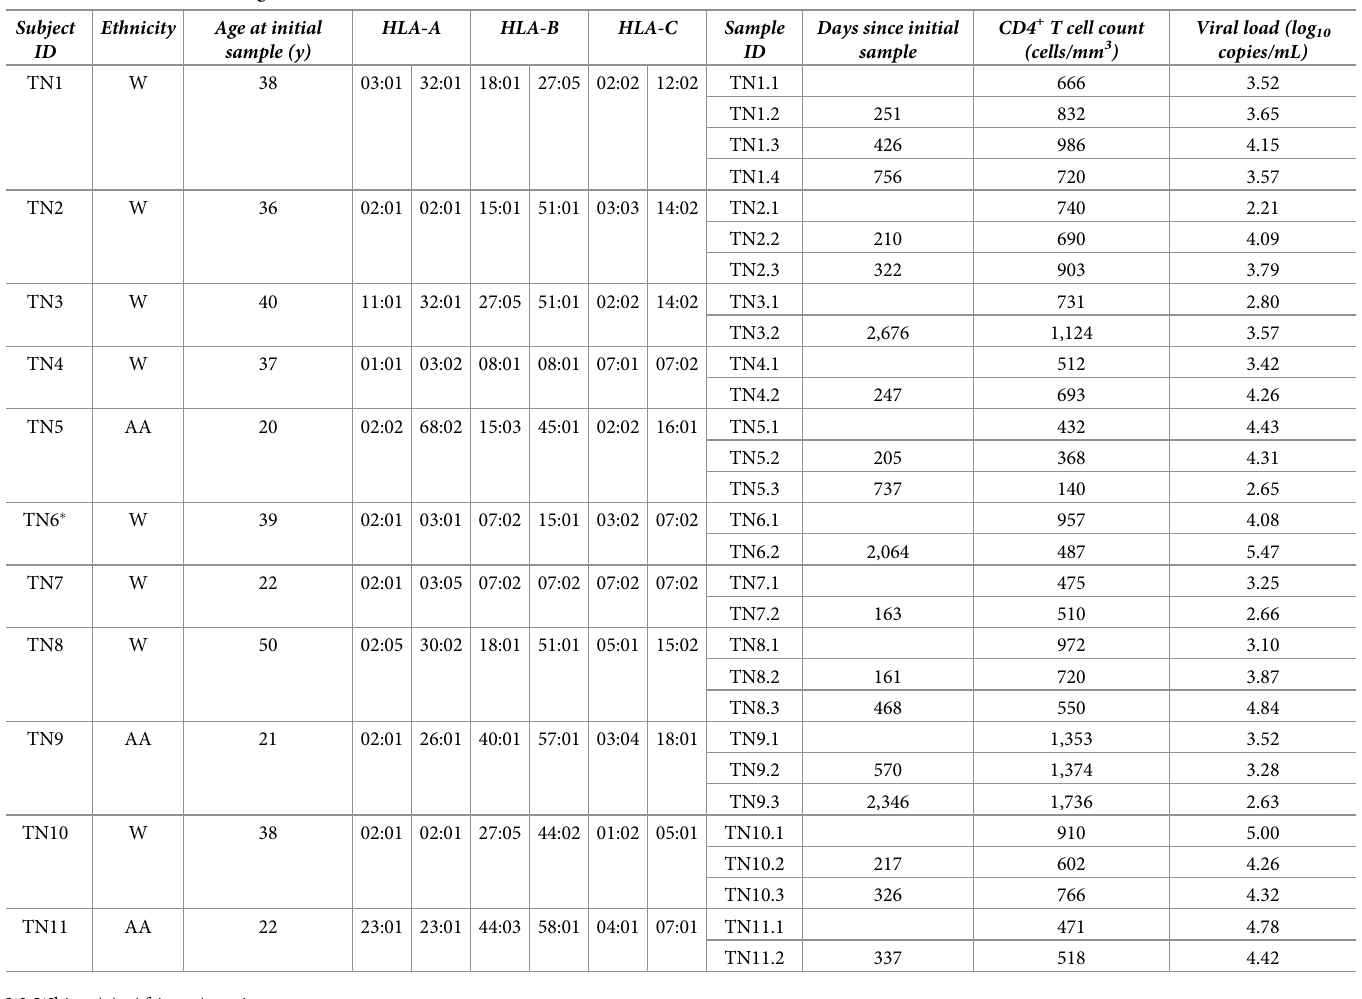
Table 2. Clinical and immunogenetic characteristics of TN